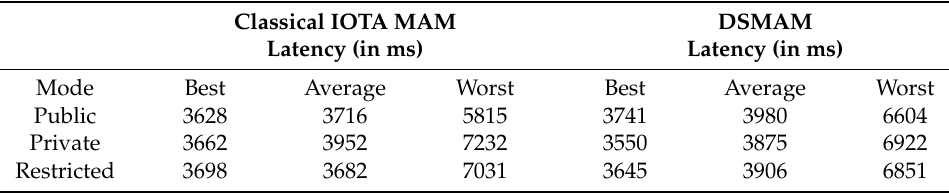
Figure 21. Comparison of latency between IOTA MAM and our proposed DSMAM . Table 8. Latency comparison between classical IOTA MAM and DSMAM .